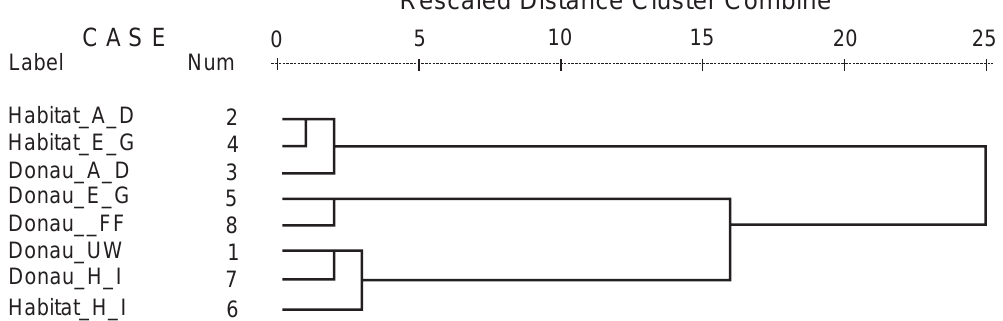
Figure 3. Cluster Analyses of the pooled habitats based on fish frequencies: Donau_UW refers to Tailwater; Donau_A_D refers to the Impoundment; Donau_E_G refers to Transition Zone; Donau_H_I refers to Head of Reservoir; Donau_FF refers to Free Flowing